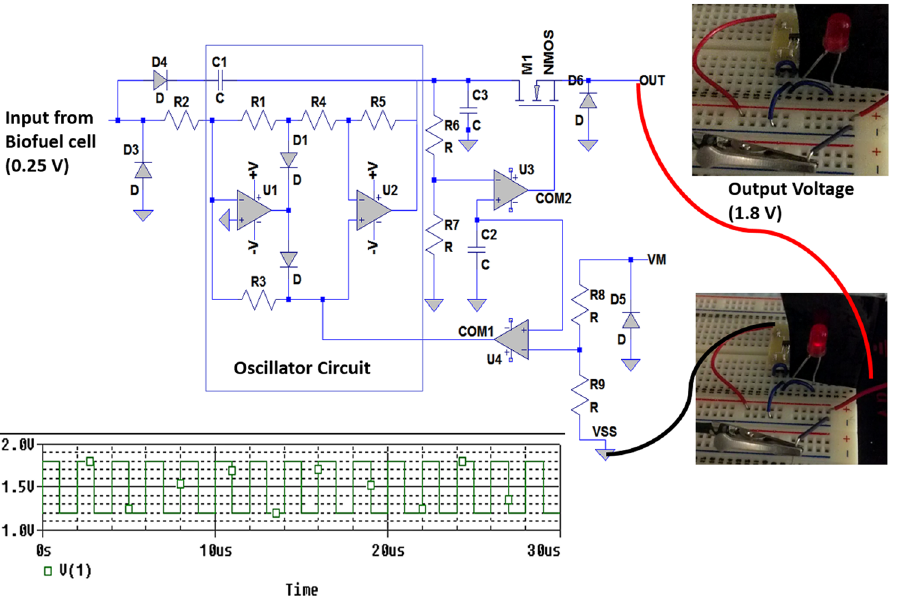
Figure 4. Schematic diagram of the charge pump circuit. The input electrical power from the enzymatic glucose biofuel cell drives the charge pump circuit, wherein the voltage is amplified and charged into the capacitor until it reaches 1.8 V. After which the circuit switch discharges the capacitor and enables current to be supply to the light emitting diode (LED) as a pulsed wave voltage between 1.2 to 1.8